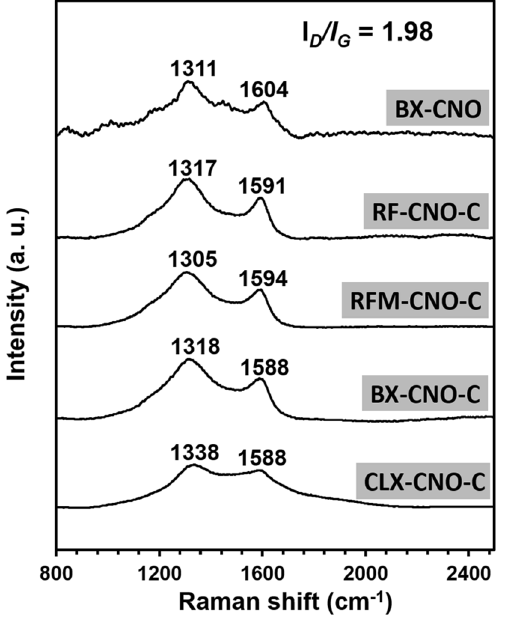
Figure 4. Raman spectra of BX-CNO , RF-CNO-C , RFM-CNO-C , BX-CNO-C , and CLX-CNO-C